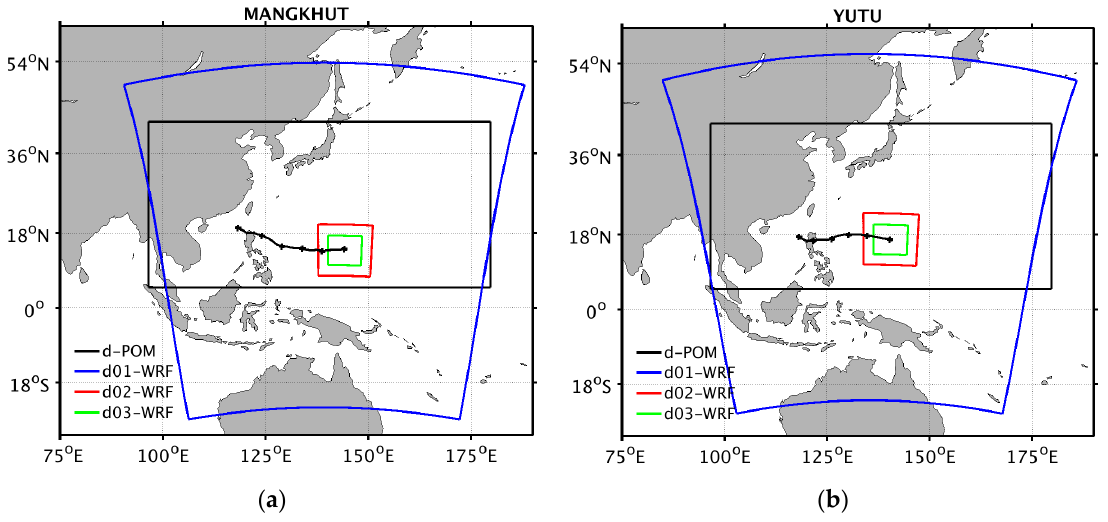
Figure 1. ( a ) The HWRF model triple nested domains and the ocean domain of the POM for Mangkhut at the initial time. The blue region and red and green boxes denote the parent fixed domain and the two inner moving domains for the HWRF model, respectively. The black box shows the domain of the POM. The black line with pluses at an interval of 24 h indicates the best track from the JMA for Mangkhut from 1200 UTC 10 September to 1200 UTC 15 September 2018. ( b ) Same as in ( a ) but for Yutu, with the best track from 0000 UTC 26 October to 0000 UTC 31 October